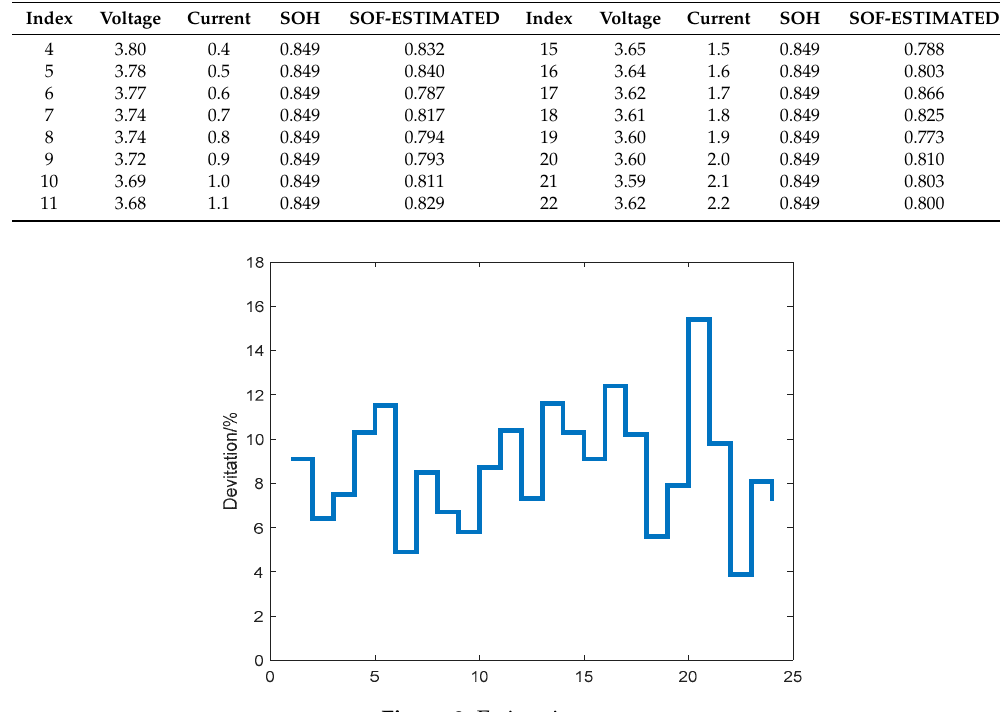
Figure 8. Estimation error.